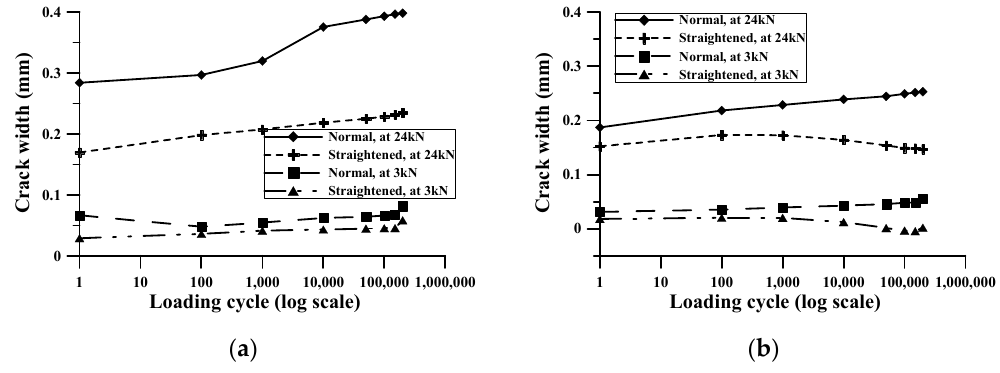
Figure 5. Crack width of the TRM under cyclic loading: ( a ) AR-glass TRM; ( b ) Carbon TRM.